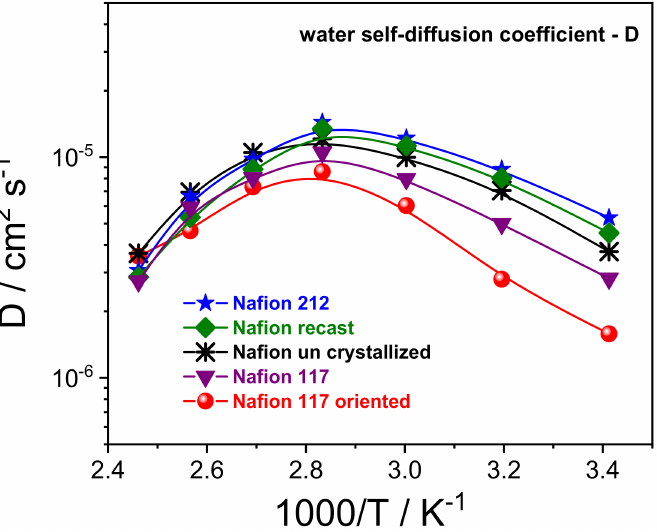
Figure 3. Self-diffusion coefficients as a function of the temperature (from 20 ◦ C to 130 ◦ C) of the water confined in the various PFSA